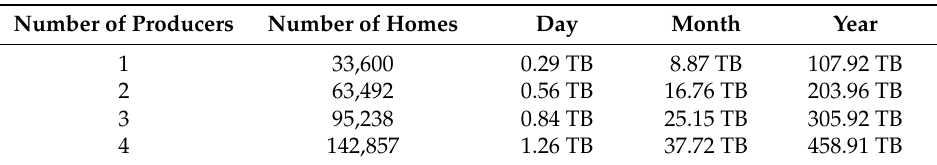
Table 2. Number of devices for UIoT-DDS.